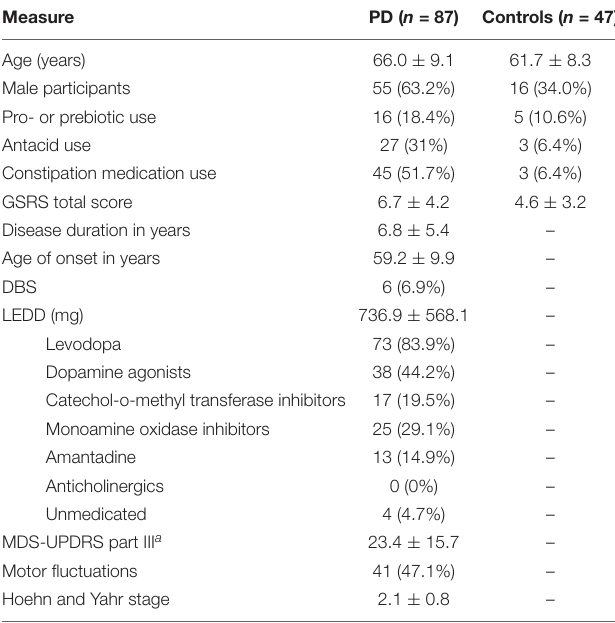
TABLE 1 | Summary statistics of demographic and clinical assessment